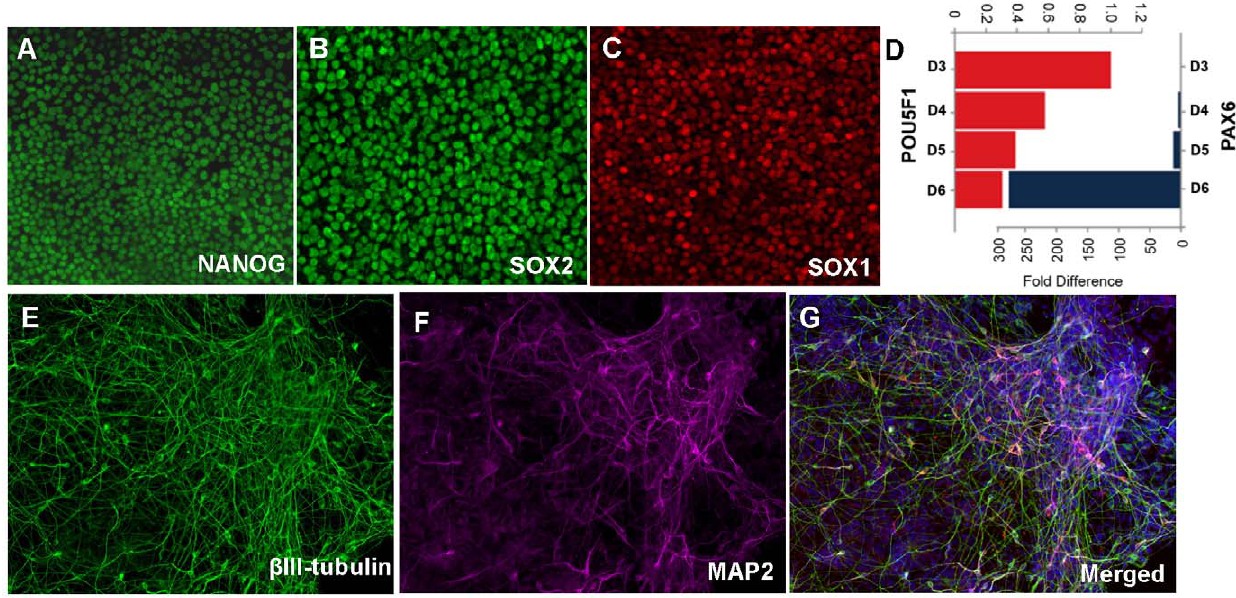
Figure 3. iPSCs generated from one dura fibroblast line express pluripotency markers and differentiate to neuronal fates. Undifferentiated iPSCs express pluripotency markers NANOG (A) and SOX2 (B). Upon neural differentiation, these cells express neuroectoderm marker SOX1 (C). Temporal gene expression analysis also shows a decrease in pluripotency marker OCT4 (POU5F1) and an increase in PAX6 expression by quantitative RT-PCR (D). iPSC-derived neurons express b III-tubulin and MAP2 (E–G).